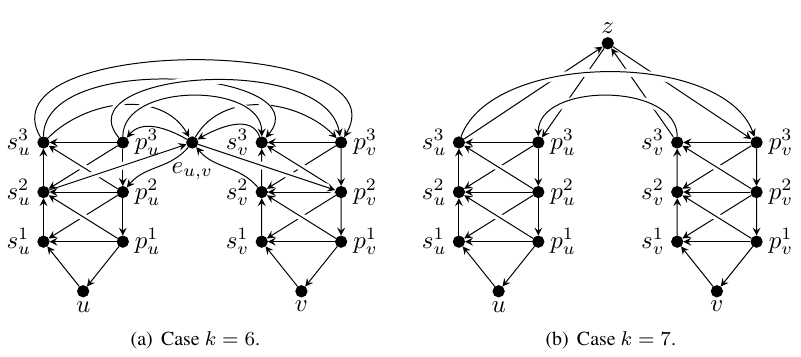
Figure 2: The gadgets G u and G v obtained for a pair { u, v } which is not